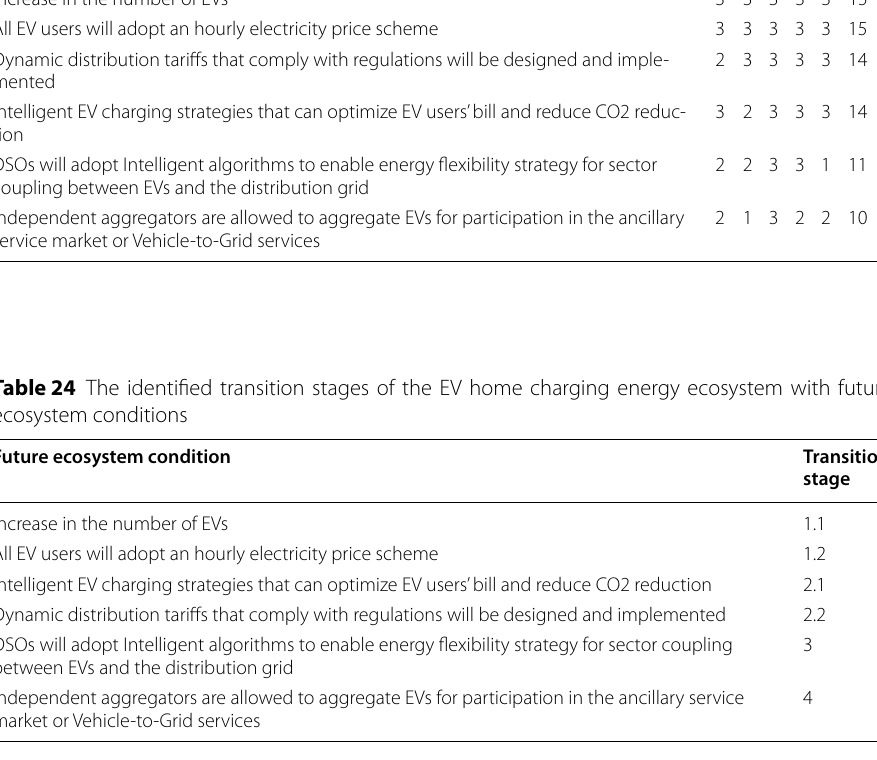
Table 23 Results of ecosystem potential change evaluation Future ecosystem condition C S T E P Total Increase in the number of EVs